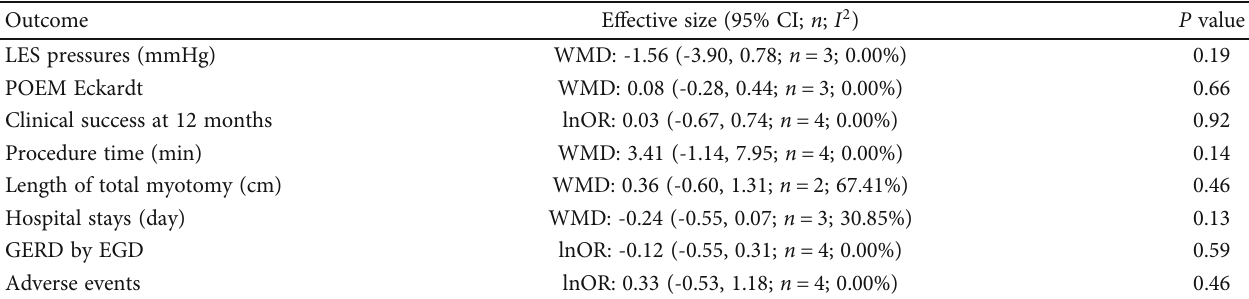
Table 4: Summary of the results in direct